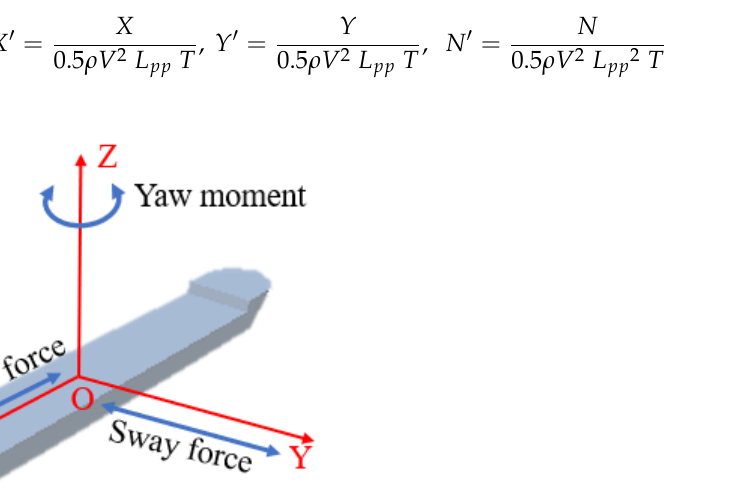
Table 3. Mesh verification results and analysis for 𝑋 (cid:4593) , 𝑌 (cid:4593) , 𝑁 (cid:4593) .